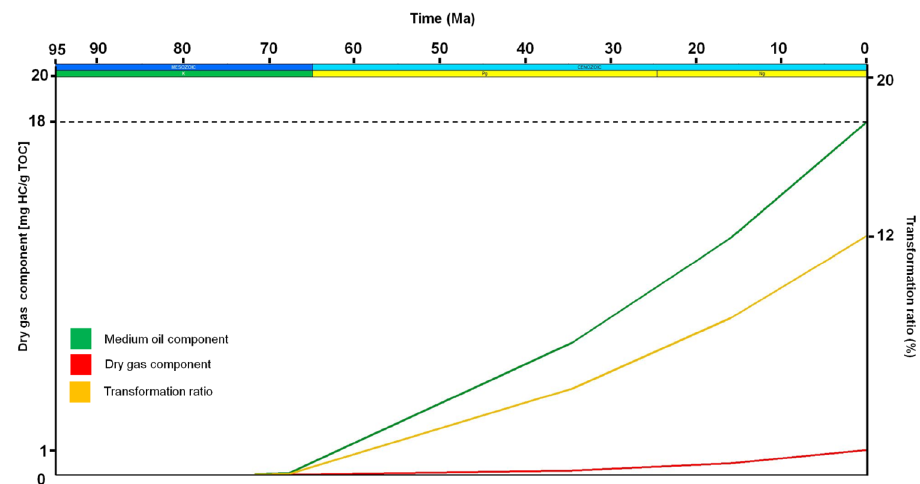
Fig. 17 Hydrocarbon multi- component and transformation ratios for Tara-1